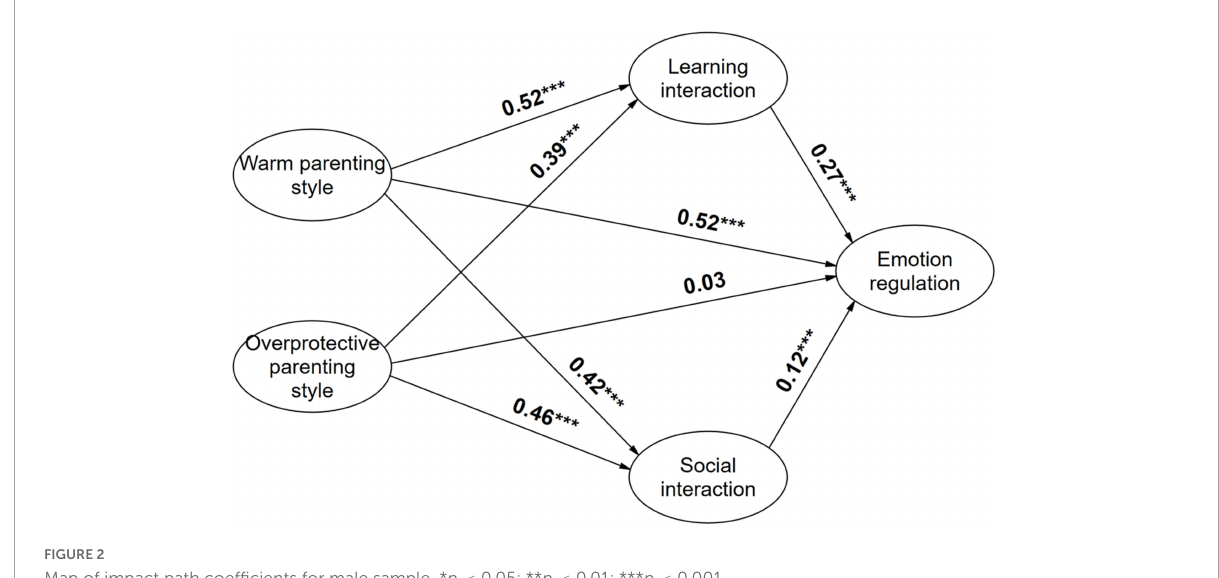
FIGURE2 Map of impact path coefficients for male sample. * p < 0.05; ** p < 0.01; *** p < 0.001.